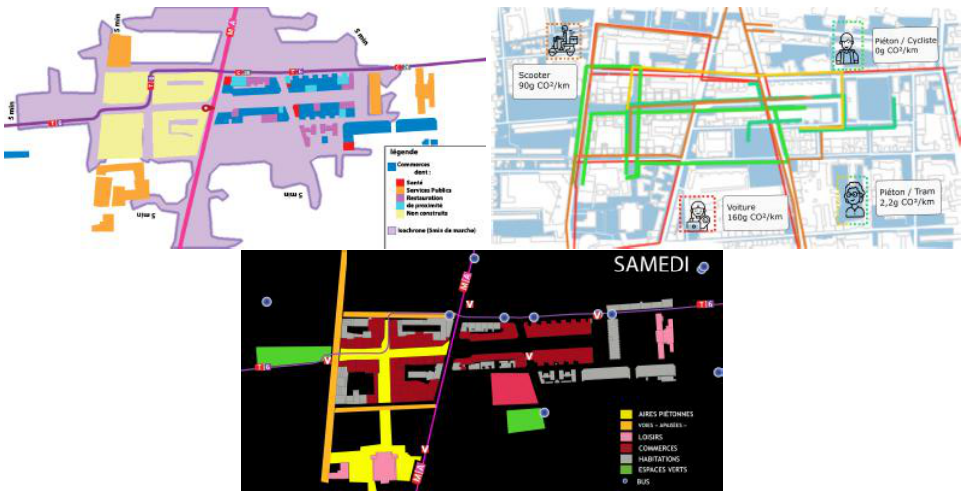
Figure 10. Three examples of image layers created by students for the slideshow. These layers can be used one after another in a presentation.